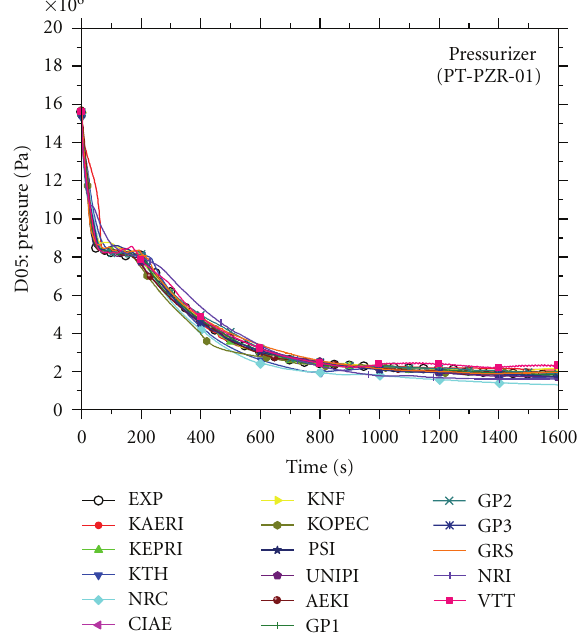
Figure 11: Comparison of the calculated primary pressures with the measurement (SB-DVI-09).